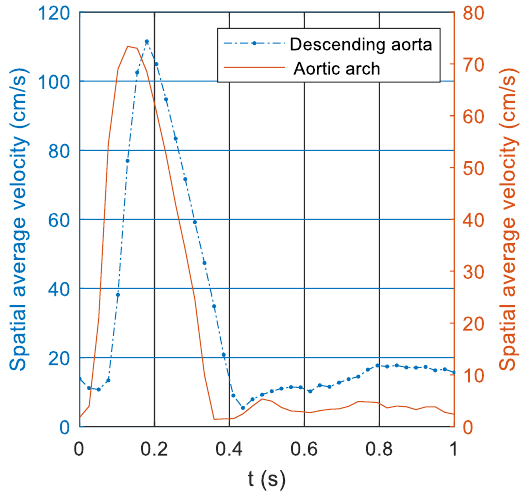
Fig.3: The spatial average time-dependent blood velocity in the aortic arch and the descending aorta.